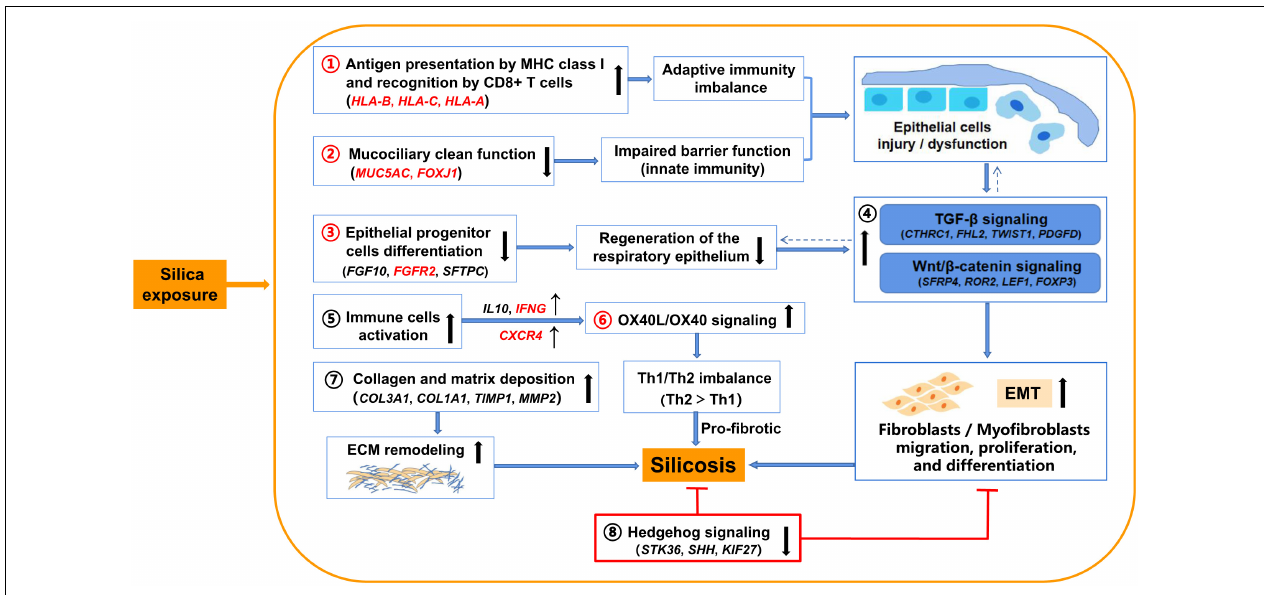
FIGURE 6 | Illustration of the proposed underlying mechanisms involved in silicosis progression based on evidence from the comparative transcriptome analysis. Silica exposure promotes silicosis progression via indicated pathways (1–8). Key pathways (1–3, and 6) and genes highlighted in red are proposed to be differentially important in silicosis compared to IPF and COPD. → : promote silicosis progression; (cid:62) : inhibit silicosis progression; ↑ : up-regulated (pathways or genes); ↓ : down-regulated (pathways or genes); ← : a cross-talk between